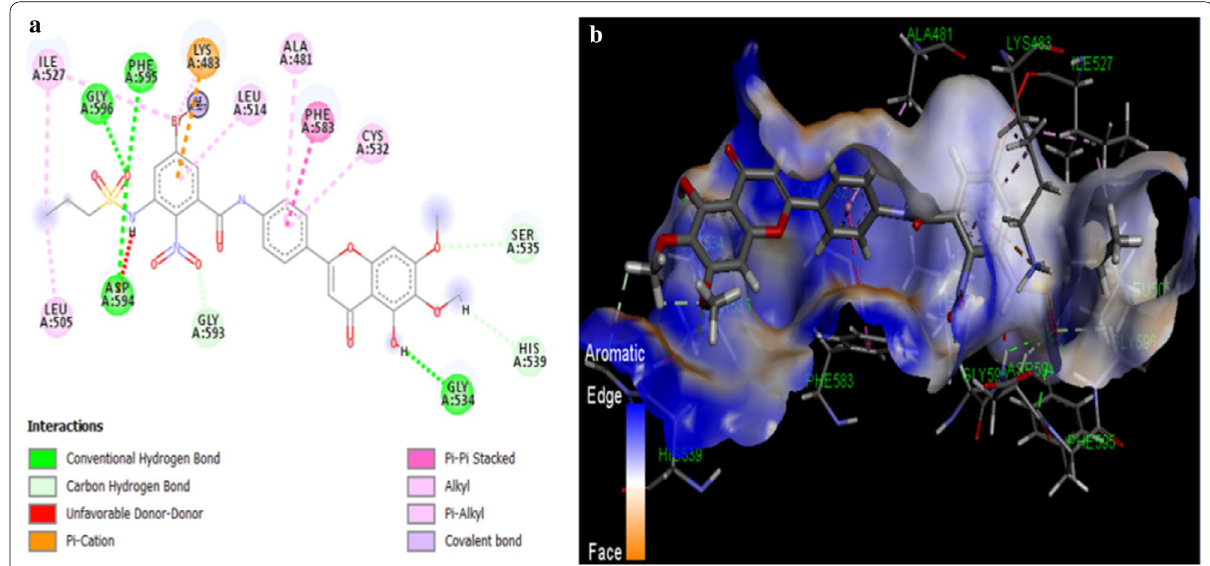
Fig. 5 a 2D diagram for the interaction of compound N3 with V600E-BRAF, b 3D view of the compound N3 in the binding site of V600E-BRAF